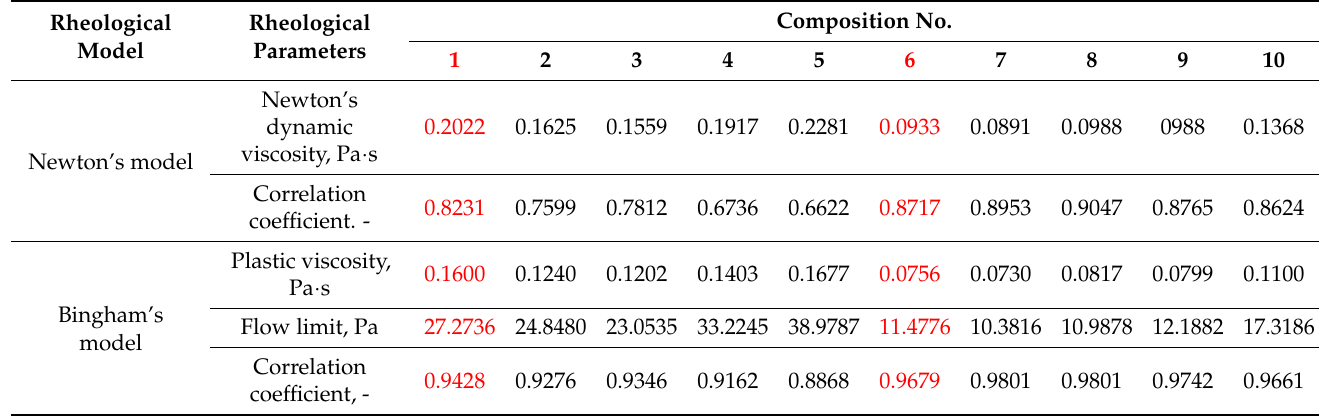
Table 9. Rheological parameters of cement